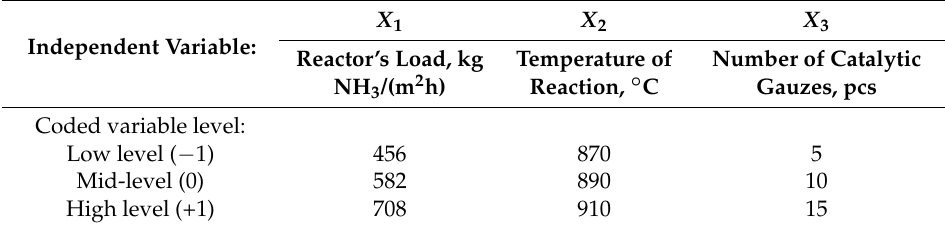
Table 9. Coded and uncoded levels of independent variables used in